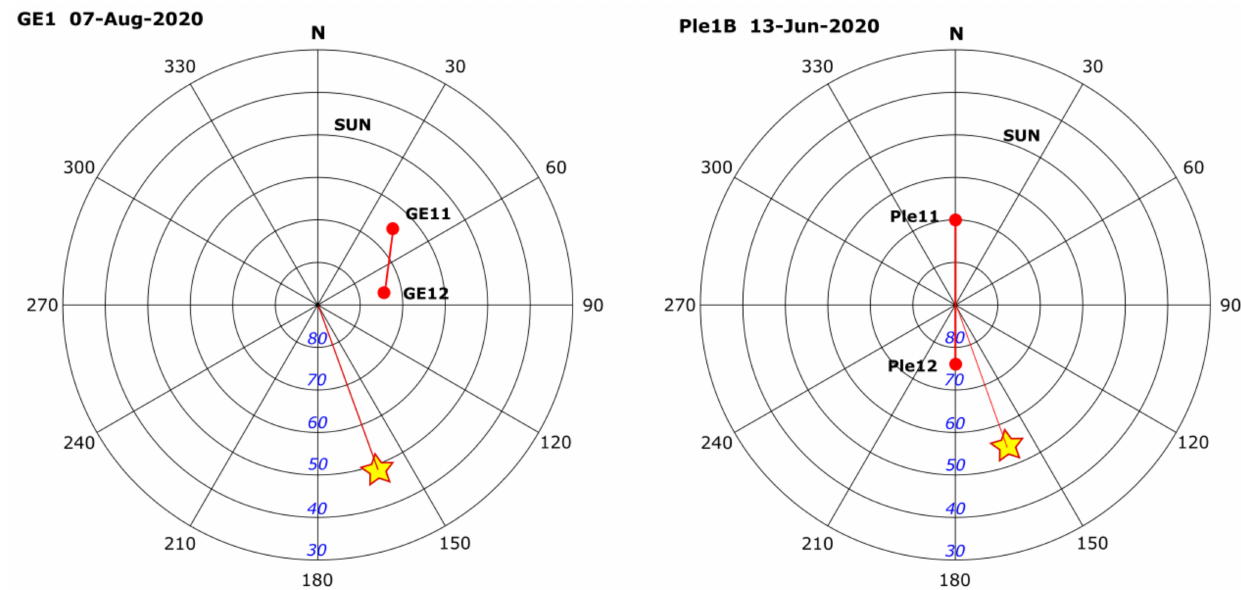
Figure 2. Polar diagrams of satellite stereo pairs: acquisition geometry describing the relative positions (elevation and azimuth angles) of the sun (yellow stars) and the sensors (red dots) to the target (circle centre). The given numbers of sensor positions (GE11, GE12, Ple11, Ple12), in each stereo pair, corresponding to acquisition time and catalogue order. All angles are given in